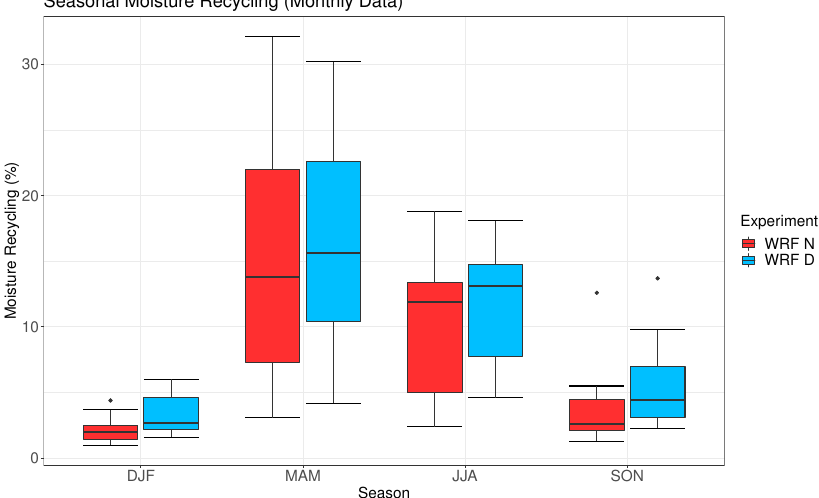
Figure 6. Monthly values of moisture recycling for WRF N and WRF D (in red and blue, respectively) along each season.